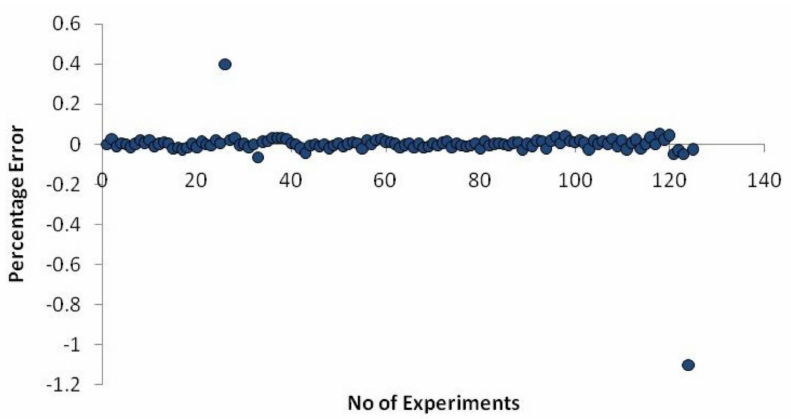
Figure 24. Error graph of network 4-9-3 for angular distortion with time gap between three passes.